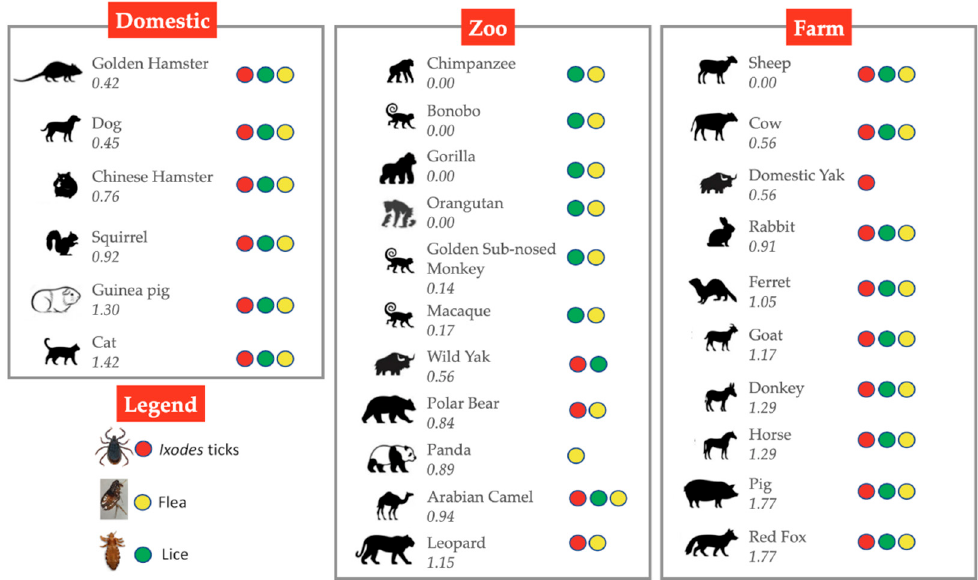
Figure 6. Animal hosts for ectoparasites. These animal hosts may be in contact with humans in domestic, agricultural or zoological settings. Numbers represent the predicted change in binding energy ( ΔΔ G) of the S-protein:ACE2 [31]. Supporting references [80–83].